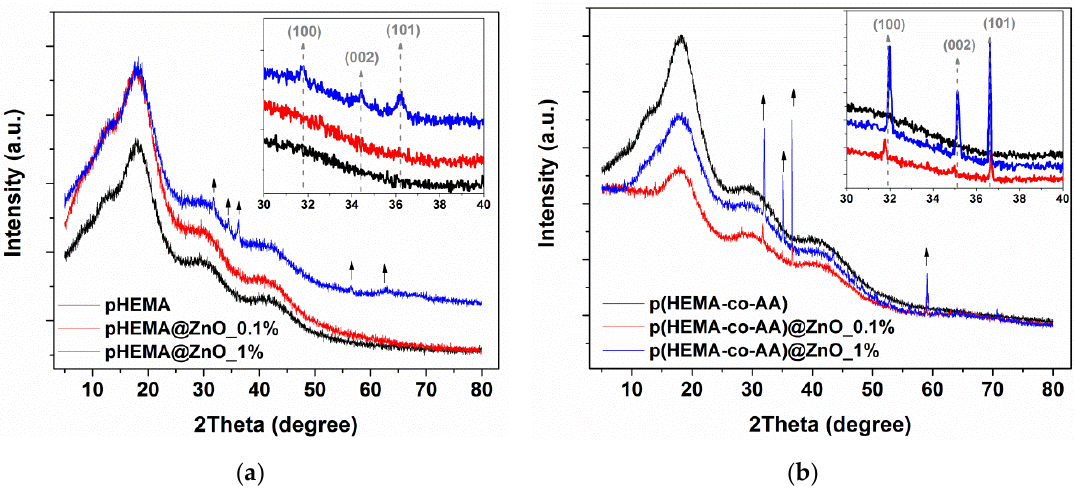
Figure 3. XRD patterns of ( a ) polyHEMA@ZnO and ( b ) poly(HEMA-co-AA)@ZnO composite samples incorporating different amounts of ZnO. For each panel, arrows indicate the diffraction peaks coming from wurtzite ZnO phase. Insets show a magnification of the XRD region showing the rise of the main peaks due to (100), (002) and (101) ZnO phase.